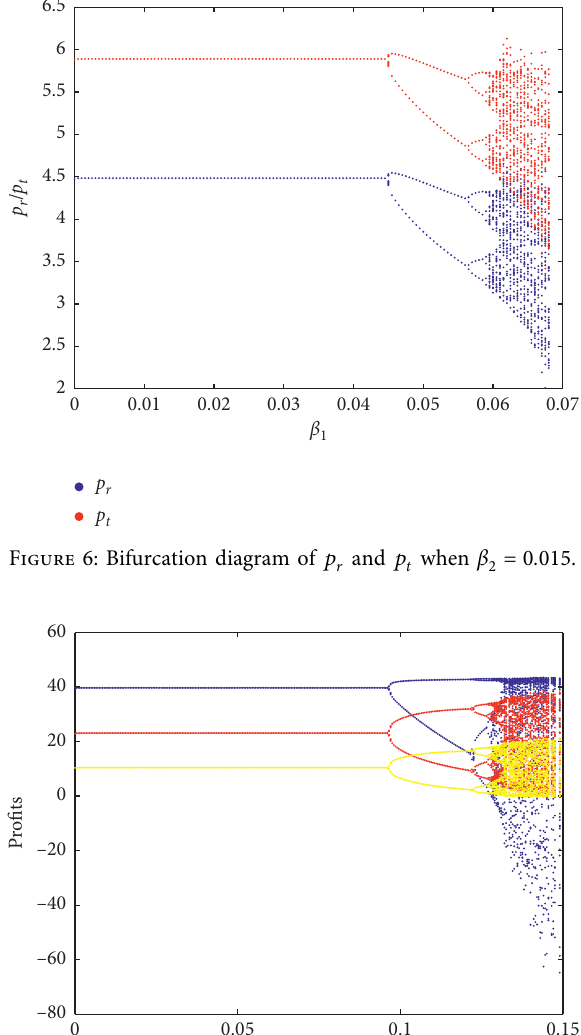
p � 0 . 0085. r and t when β 1